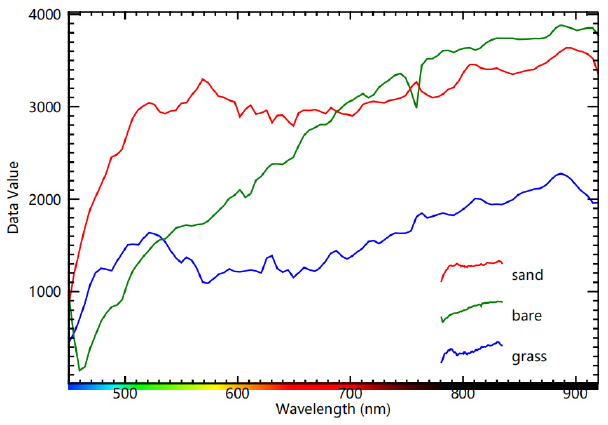
Figure 7. Spectral curves of different features.